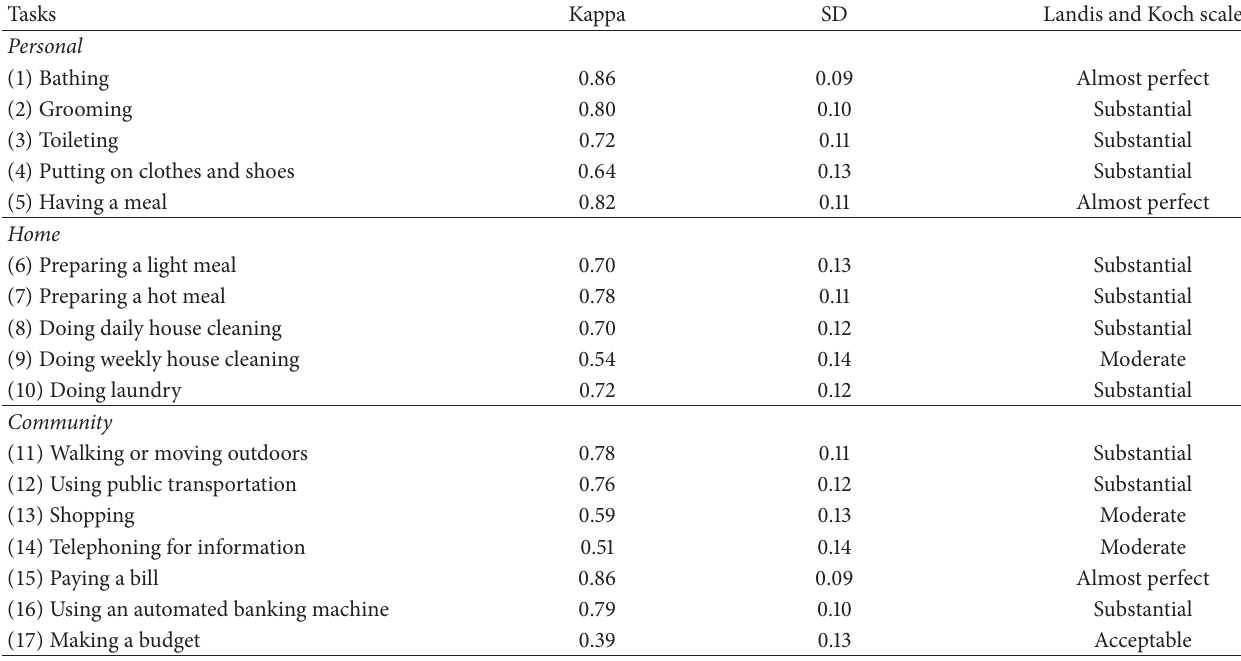
Table 5: Test-retest reliability of the operation of verifying the attainment of the initial